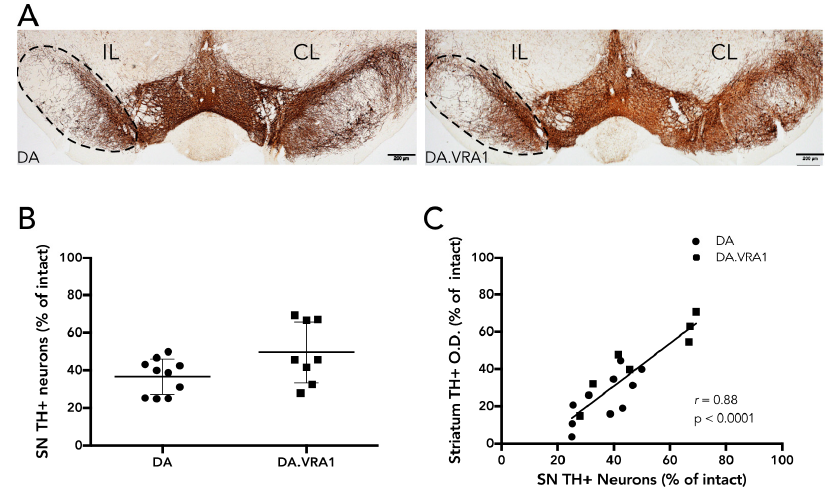
Figure 2. Loss of dopaminergic cells in the SNpc 8 weeks after striatal 6 ‐ OHDA lesion. ( A ) Representative images showing the loss of TH+ cells in SNpc of DA and DA.VRA1 rats. Delineated areas outline the SN IL to the lesion. Scale bar = 500 μ m. ( B ) Stereological quantification of TH+ neurons in the SNpc at 8 weeks post 6-OHDA lesion. Individual data points and mean ± SD are shown after unpaired t -test ( p = 0.052). ( C ) The Pearson correlation coefficient ( r ) shows that the percentage of remaining TH+ cells in the SNpc strongly correlates with the density of TH+ fibers in the DL striatum on the IL side. (DA = Dark Agouti; DA.VRA1 = Vra1 congenic; CL = Controlateral; IL =